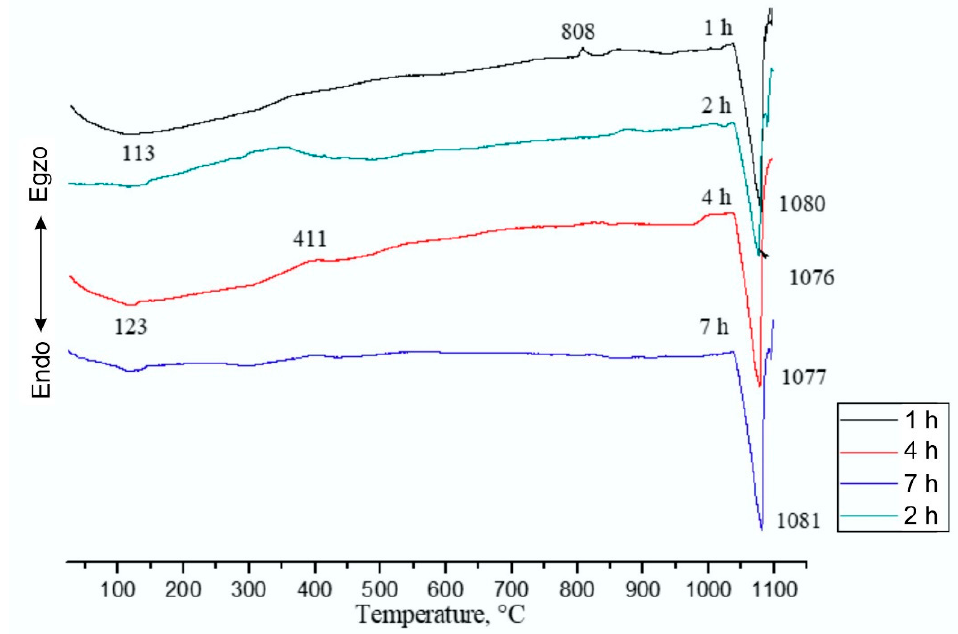
Figure 8. DTA curves of tested samples.